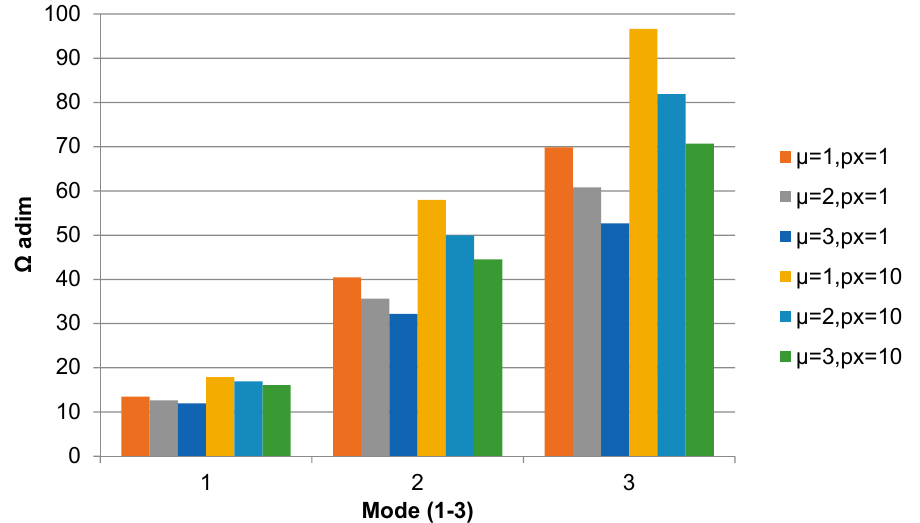
Figure 8. FGM2-X nondimensional frequencies ( Ω adim ) for different vibration modes. L/h = 10.